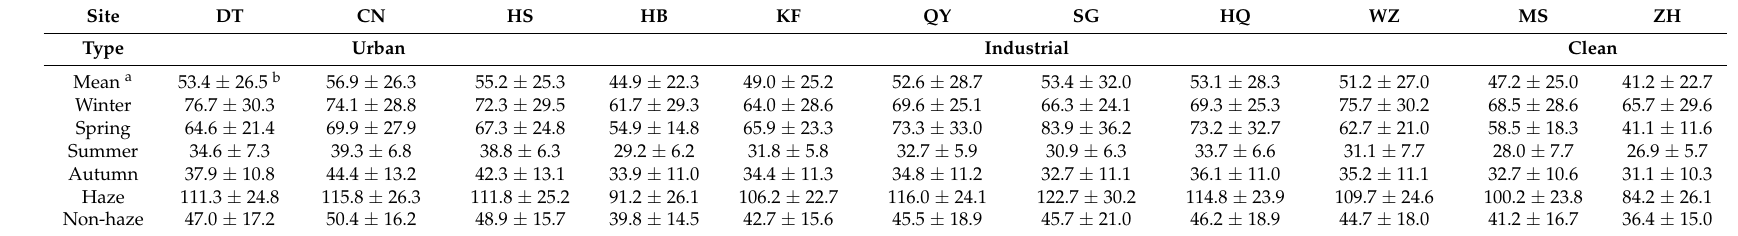
Table 1. Summary of average PM 2.5 mass concentrations ( µ g/m 3 ) of 11sites of different seasons as well as during hazeand non-haze periods.